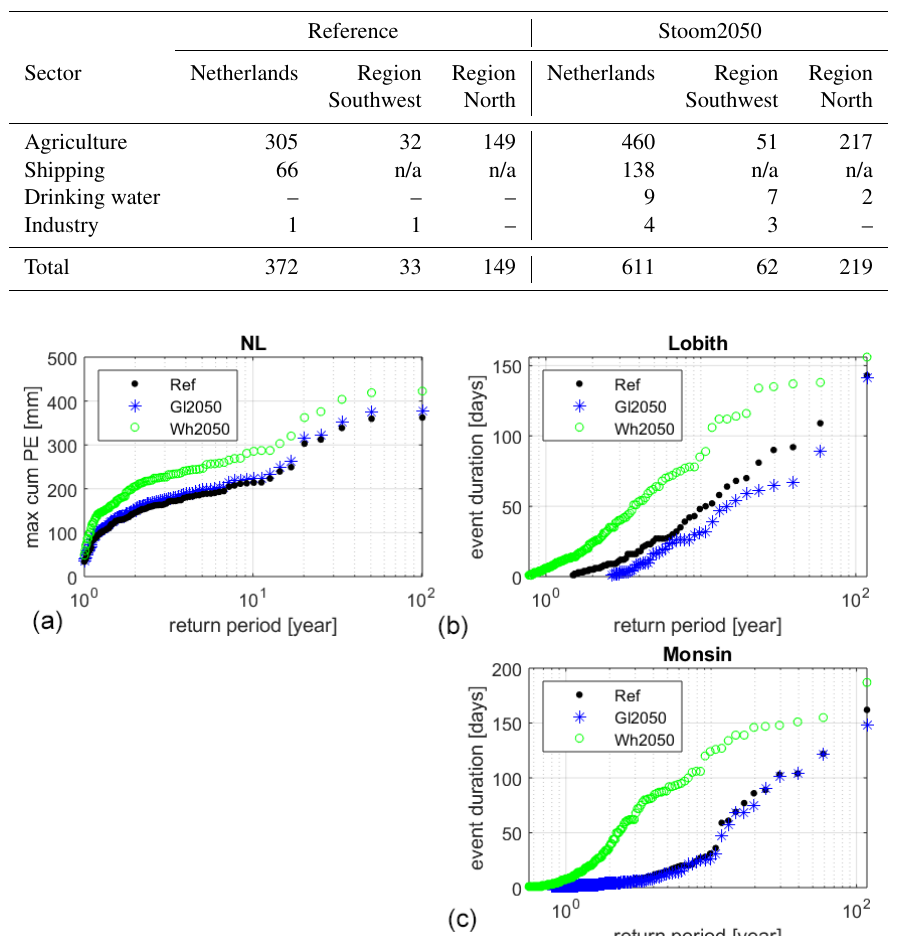
Figure 4. Change in meteorological and hydrological drought probability in the two climate scenarios G L and W H , measured as the maximum cumulative precipitation deficit in millimetres (a) and the duration of low flows in the Rhine (b) and Meuse (c) in days. Only periods with a minimum duration of 7d are